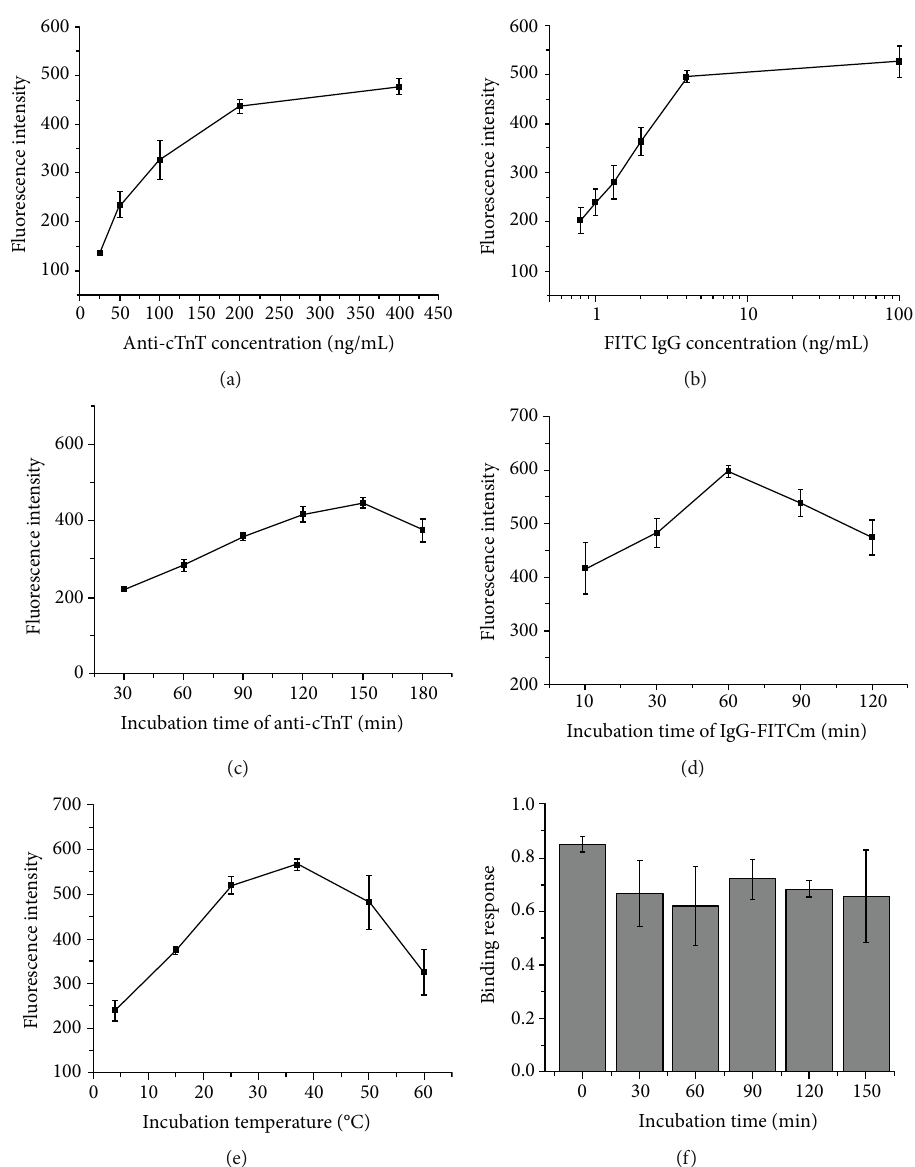
Figure 3: (a) MFI of magnetic microspheres – -cTnT incubated with di ff erent concentrations of anti-cTnT at 25, 50, 100, 200, and 400 ng/mL, respectively. (b) MFI of coded conjugations incubated with di ff erent concentrations of IgG – FITC, i.e., 0.8, 1.0, 1.33, 2.0, 4.0, and 100 μ g/mL or at dilution ratios of 1:2500, 1: 2000, 1 :1500, 1:1000, 1 :500, and 1:20, respectively. (c) MFI of magnetic microspheres – cTnT incubated with anti-cTnT for 30, 60, 90, 120, and 150 minutes. (d) MFI of coded conjugate incubated with di ff erent IgG – FITC concentrations for 10, 30, 60, 90, and 120 minutes. (e) Incubation temperatures of the reaction system at a range of 4, 15, 25, 37, 50, and 60 ° C. (f) Binding response of cTnT in the samples or standard with anti-cTnT at the fi rst reaction